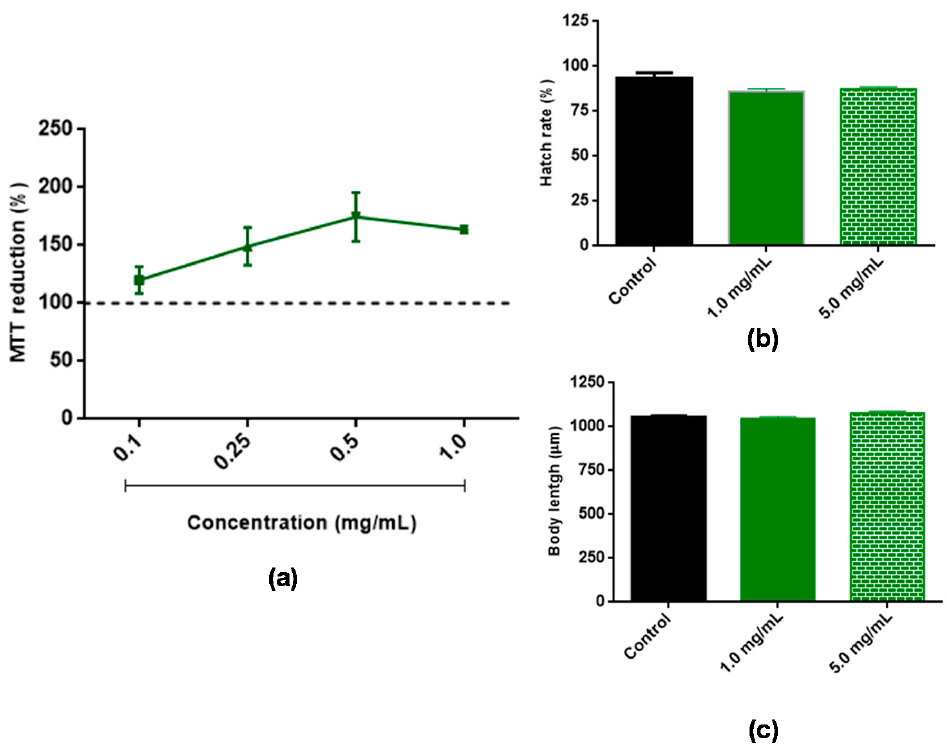
Figure 2. Evaluation of the toxicity of Baccharis trimera leaf extract (BT). ( a ) Effect of BT on MTT reduction capacity of 3T3 cells. ( b ) Effect on hatch rate of Caenorhabditis elegans eggs. ( c ) Effect on body length of worms. Cells were cultured in the presence of different concentrations (0.1–1.0 mg/mL) of BT for 24 h. The animals were exposed to 1.0 and 5.0 mg/mL of BT. Cell viability was measured using the MTT test. The dotted line represents the negative control. The letter a indicates significant differences between the different concentrations and the control according to ANOVA followed by the Tukey test ( p < 0.01). MTT: 3-[bromide 4,5-Dimethyl-thiazol-2-yl]-2,5-diphenyltetrazolium; ANOVA: analysis of